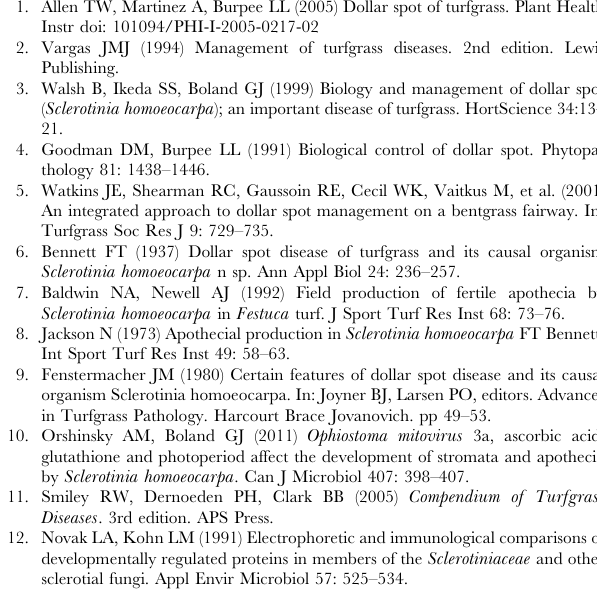
Figure S2 Sensitivity of Sclerotinia homoeocarpa -spe- cific primers in primary and nested PCR. Primary PCR